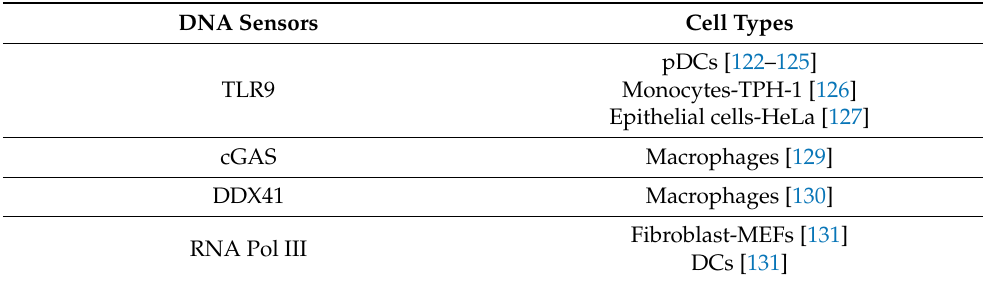
Table 2. DNA sensors activated during adenoviral infection and the cell types in which they have been